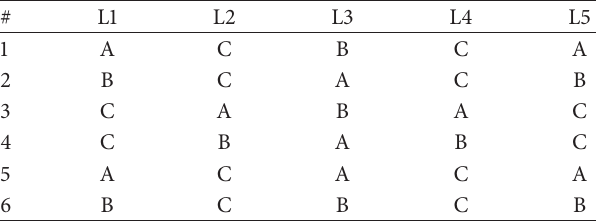
Table 1: GFRP hybrid fibre arrangement of layer L1–L5.